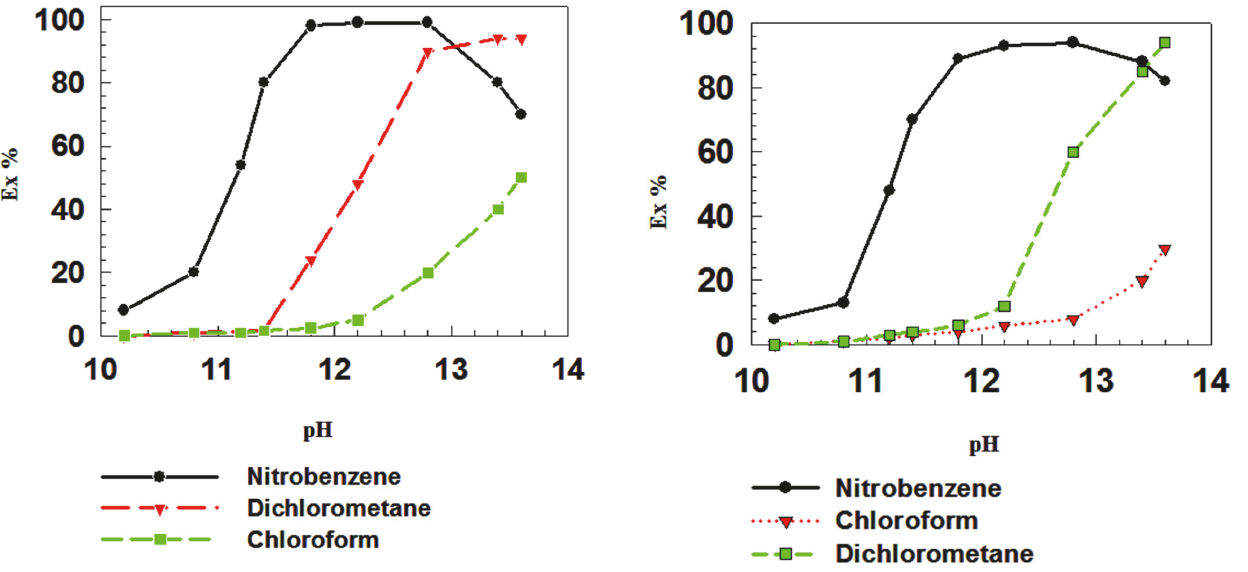
Figure 3: Effect of the organic solvent (nitrobenzene, dichloromethane, or chloroform) on the extraction percentage of Ni 2+ with H 8 L. p -calix [8] = 5 × 10 −4 M; aqueous phase [metal ion]: = ( e ) 5 × 10 −5 M. succinic acid = 0.01 M and buffer solution, O/A = 1; T = 25 ∘